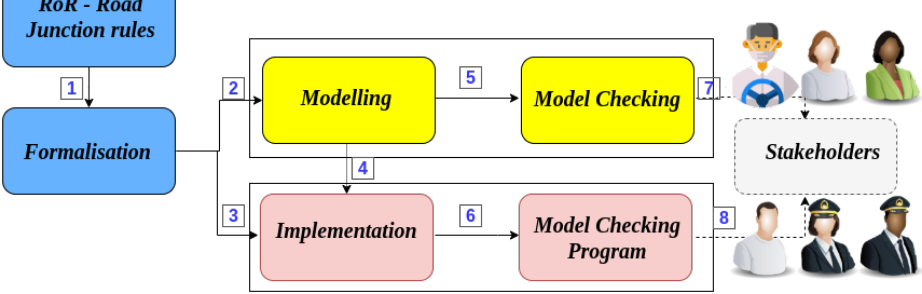
Figure 1. Proposal: SAE-RoR